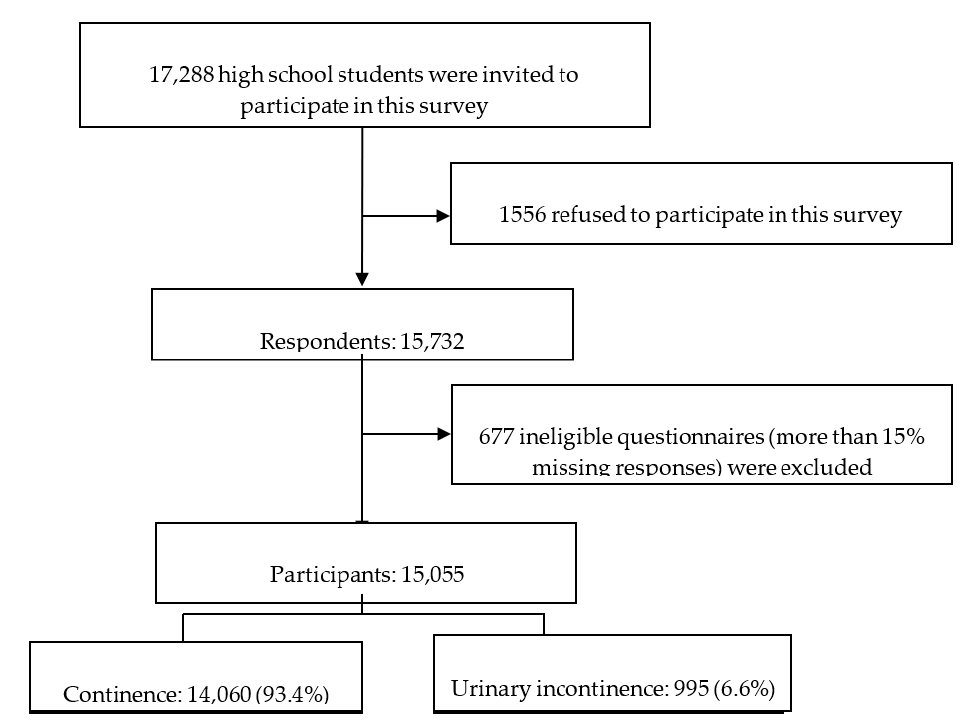
Figure 1. Flowchart of participants through this study.